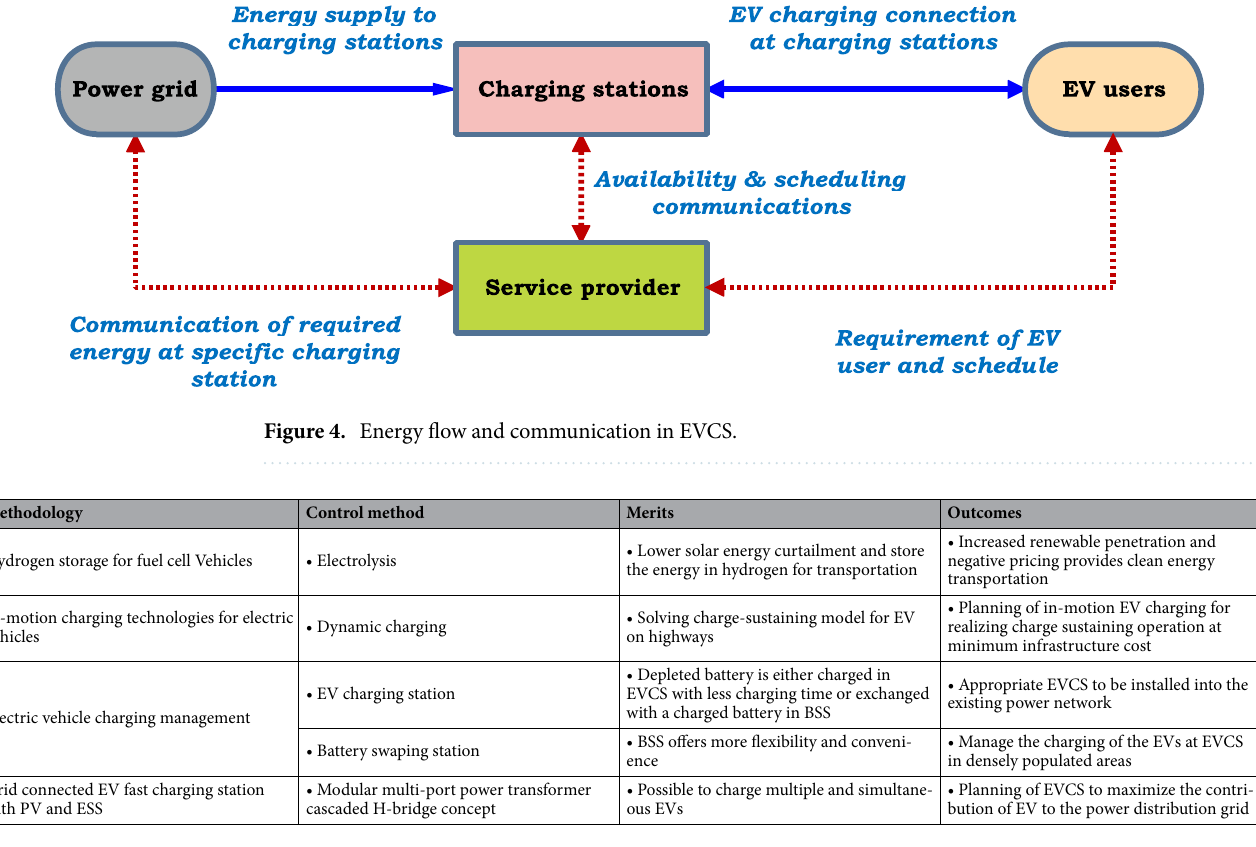
Table 2. EV charger and charging infrastructure in smart